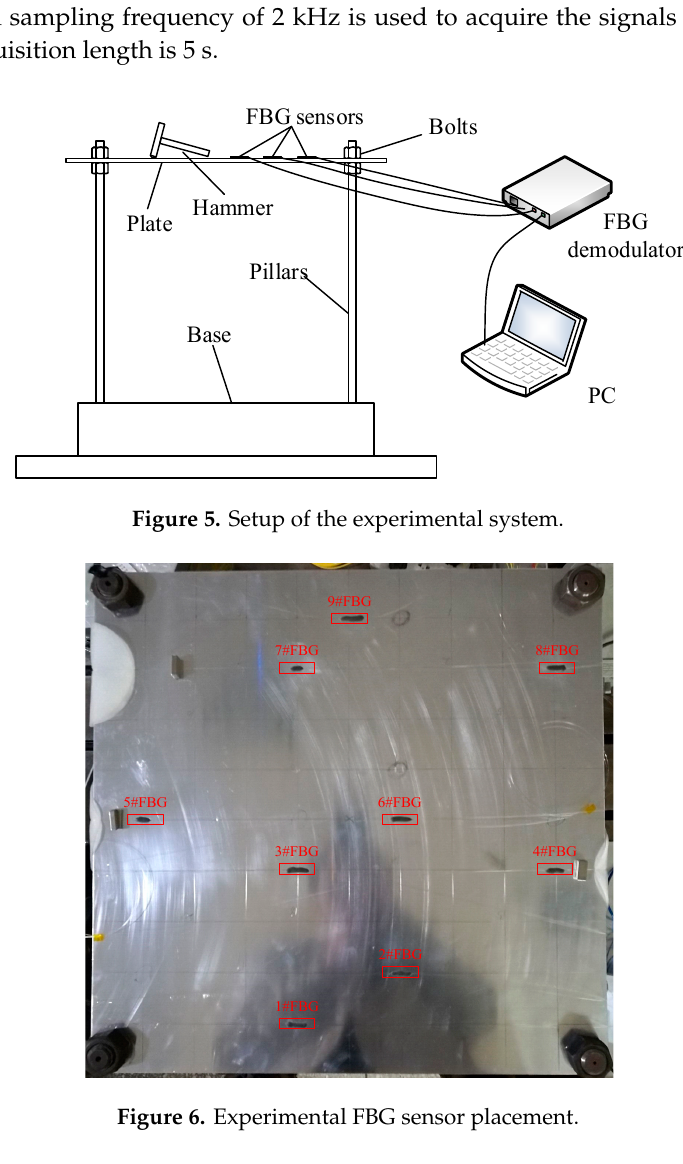
9 of 18 Figure 4. Damage index map with random noise: ( a ) damage case 1 and ( b ) damage case 2.